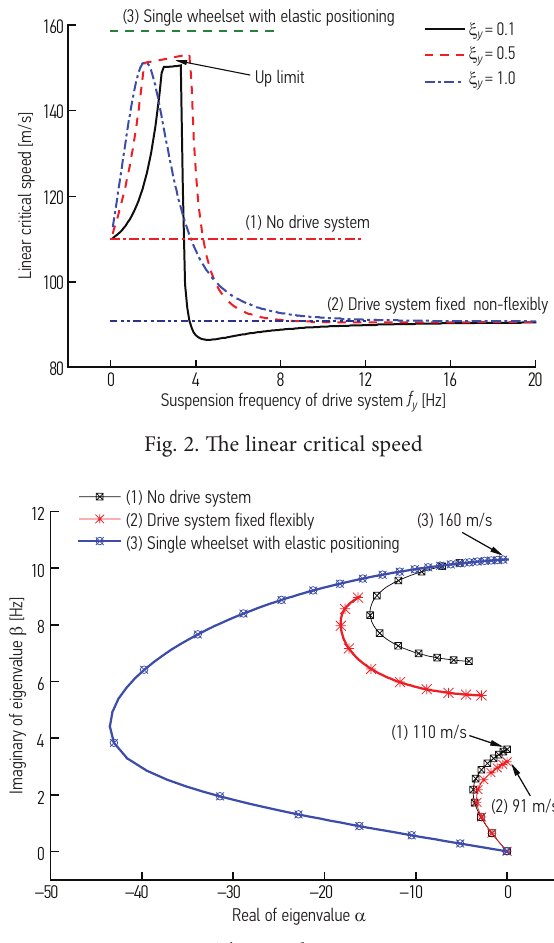
Fig. 3. The root locus curves